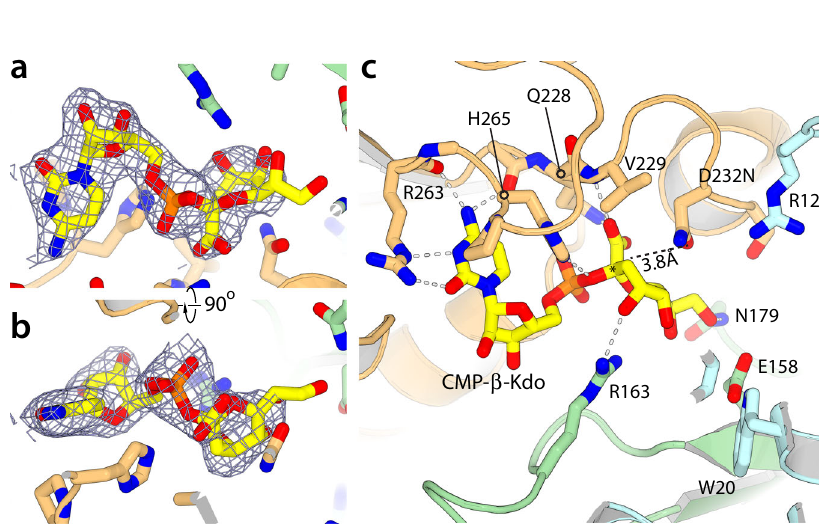
Fig.3|StructureoftheWbbB GT99 CMP- β -Kdocomplex.a , b Orthogonalviewsof the electron density for CMP- β -Kdo (blue mesh is the 2mFo-DFcmap contoured at 1.0 σ ). c DetailsofinteractionsmediatedbyCMP- β -KdointheWbbB GT99